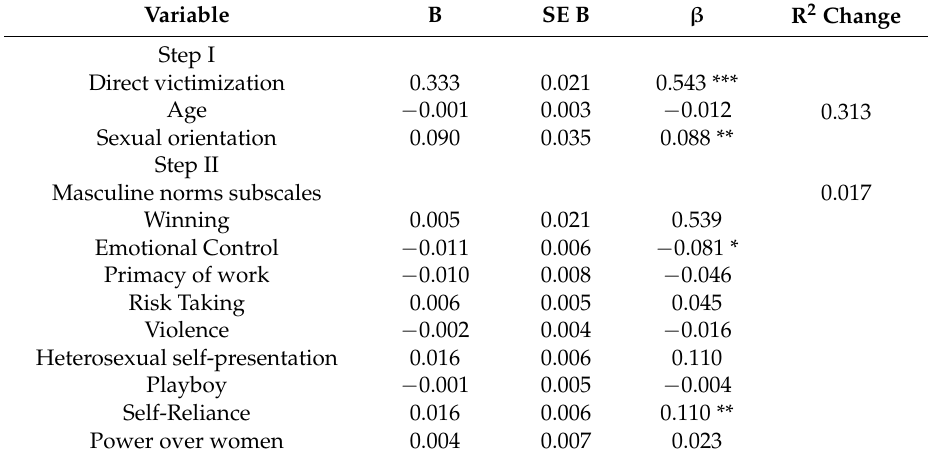
Table 3. Hierarchical regression analysis analyzing the association between masculine norms and direct cyber dating